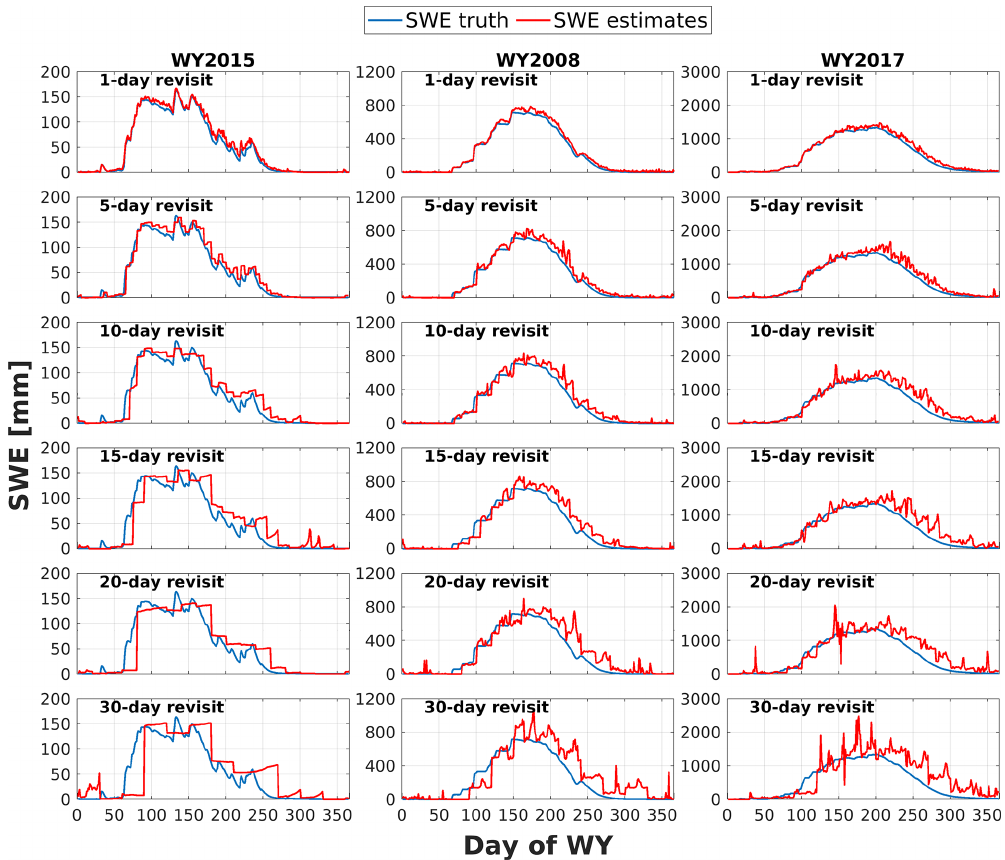
Figure 6. Daily time series of basin-averaged SWE truth (blue line) and DNN-based SWE estimates (red line) in a dry year (WY2015), a normal year (WY2008) and a wet year (WY2017) for daily, 5, 10, 15, 20 and 30d revisits (rows 1–6,